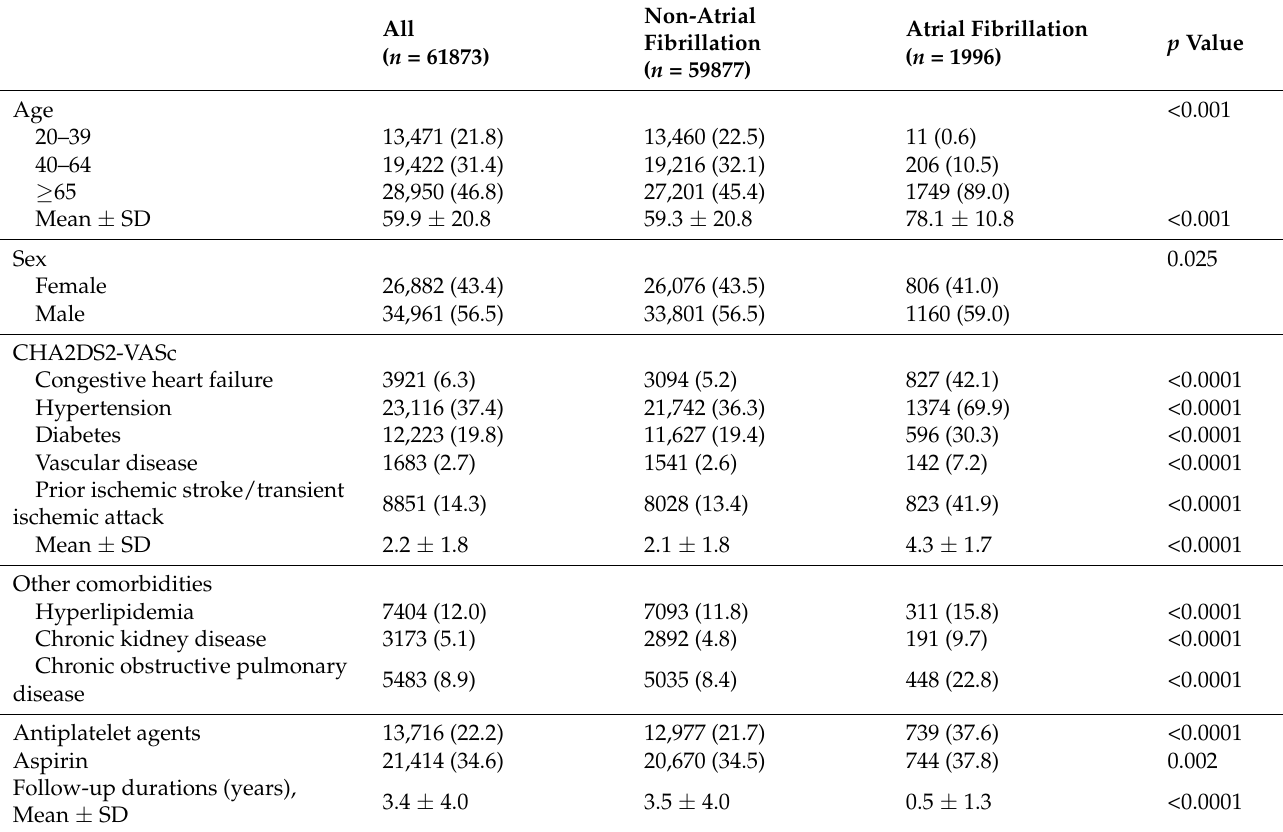
Table 1. Demographic characteristics of pneumonia patients with and without atrial fibrillation.